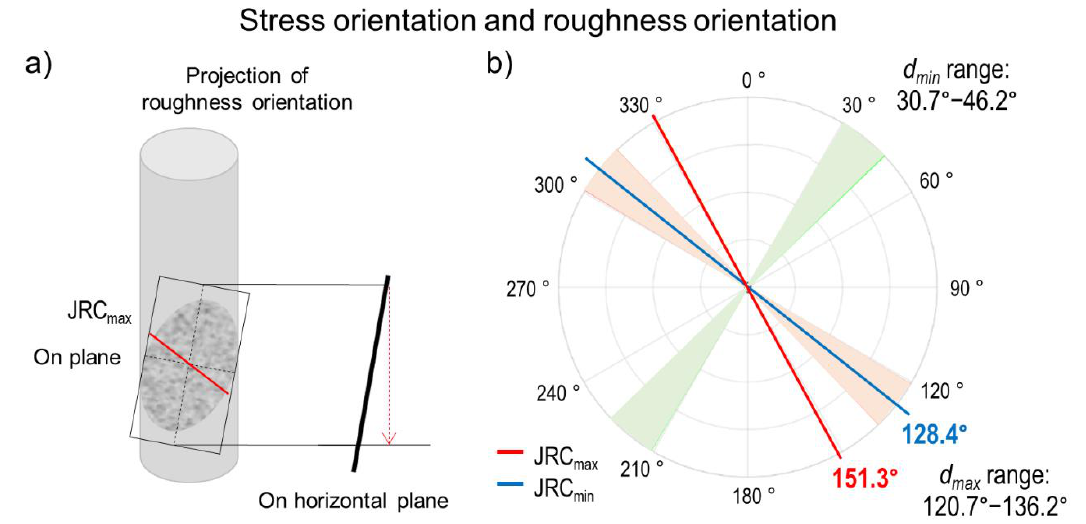
Figure 6. ( a ) Horizontal projection of JRC max and JRC min orientations on closed joint CJ-2 (dip angle of 80.8 ◦ ). ( b ) Comparison of d max and d min orientations with the horizontal projections of JRC max and JRC min orientations. As was shown in Figure 4c, the d max orientation was not a single value, but instead ranged from 120.7 ◦ –136.2 ◦ (red area), with the orientations for d min 90 ◦ apart(green area). Later, the horizontal projections of JRC max and JRC min orientations were added, and an alignment between JRC min and d max was observed.